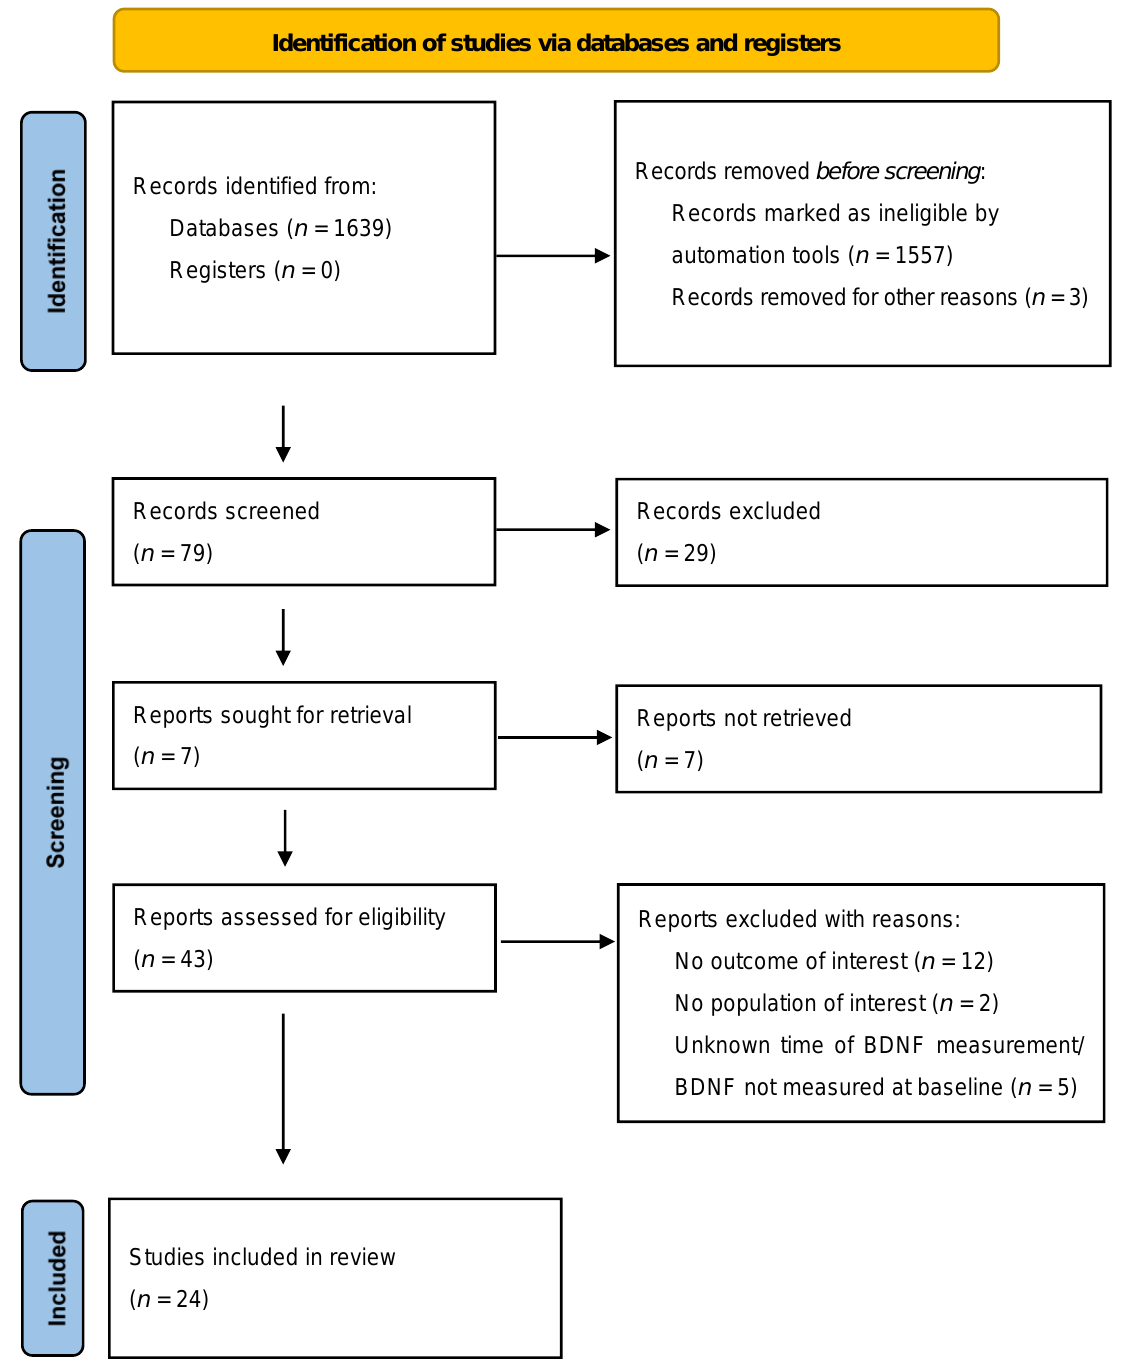
Figure 1 . The PRISMA 2020 statement. [26]. Figure 1. The PRISMA 2020 statement.